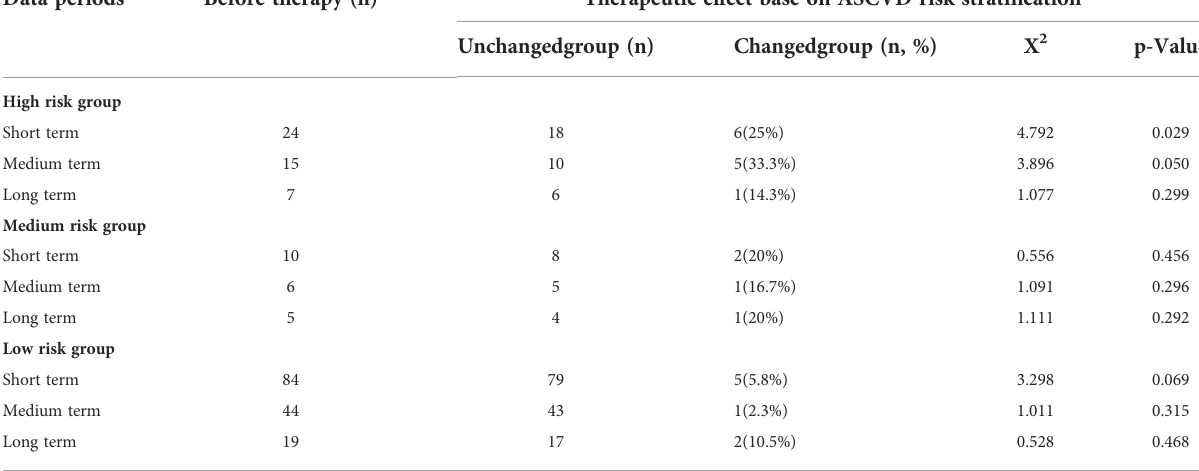
TABLE 5 Effects of short, medium, and long term treatment on atherosclerotic cardiovascular disease risk classi fi cation. Data